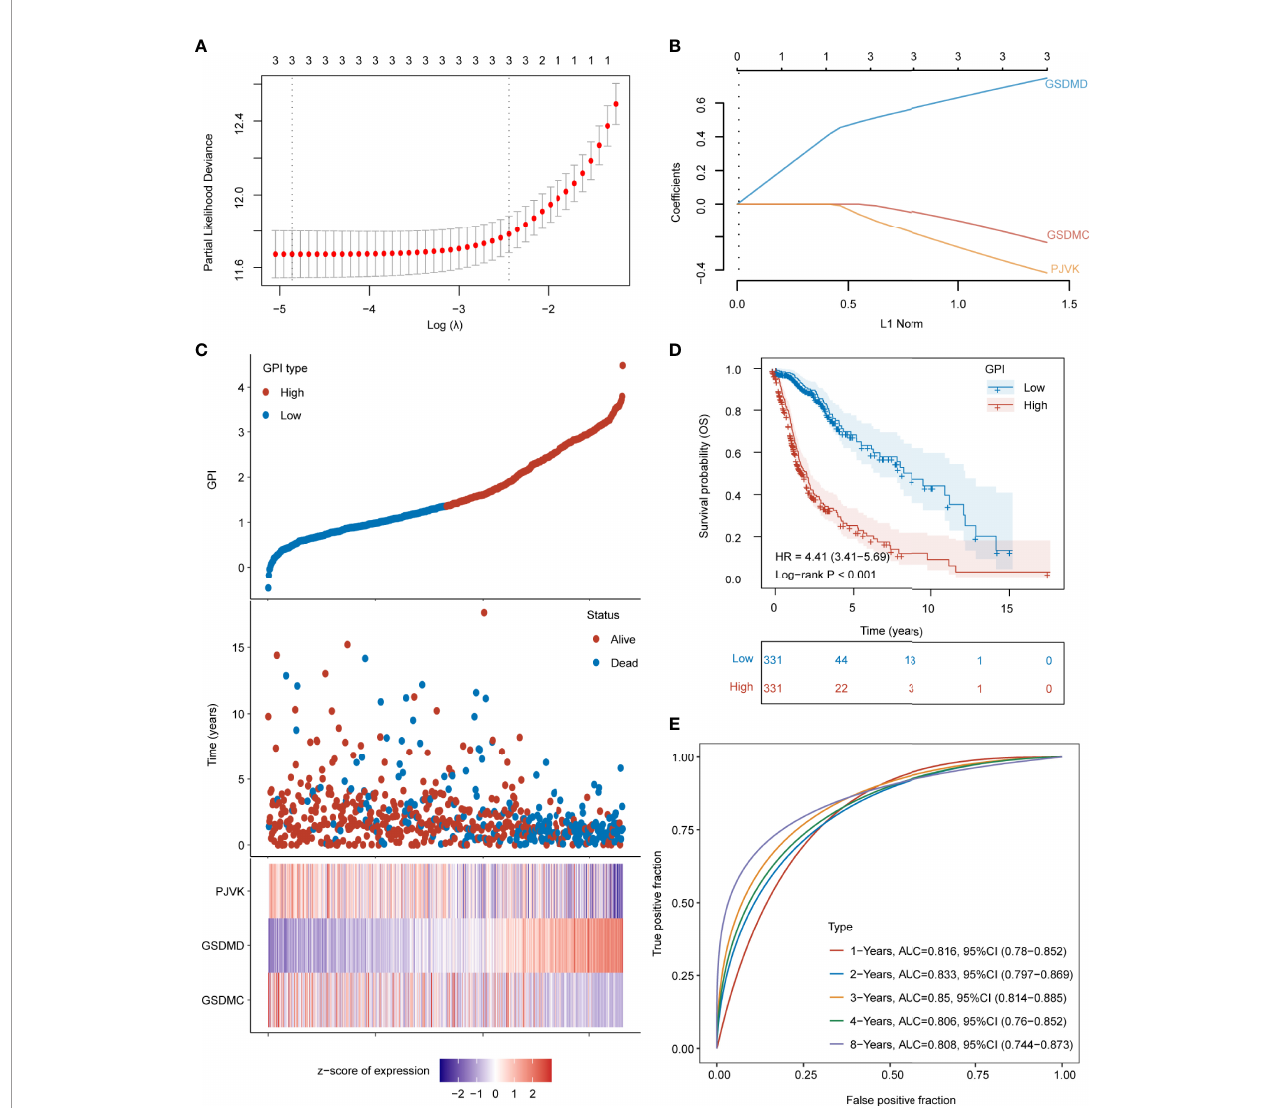
FIGURE 5 | Development of GPI for glioma. (A) Partial likelihood deviance versus log ( l ), where l is the tuning parameter. (B) The coef fi cients of GSDMC, GSDMD, and PJVK are shown by the l parameter. The abscissa represents the l value, and ordinate represents the coef fi cients of the corresponding independent variable. ( C , top) Scatterplot showing GPI from low to high; ( C , middle) scatter plot distribution represents survival time and survival status of different samples with corresponding GPI; ( C , bottom) heatmap showing GSDMC, GSDMD, and PJVK expression from GPI signature. (D) Survival analysis between GPI-high and GPI-low groups. (E) ROC curve of GPI for